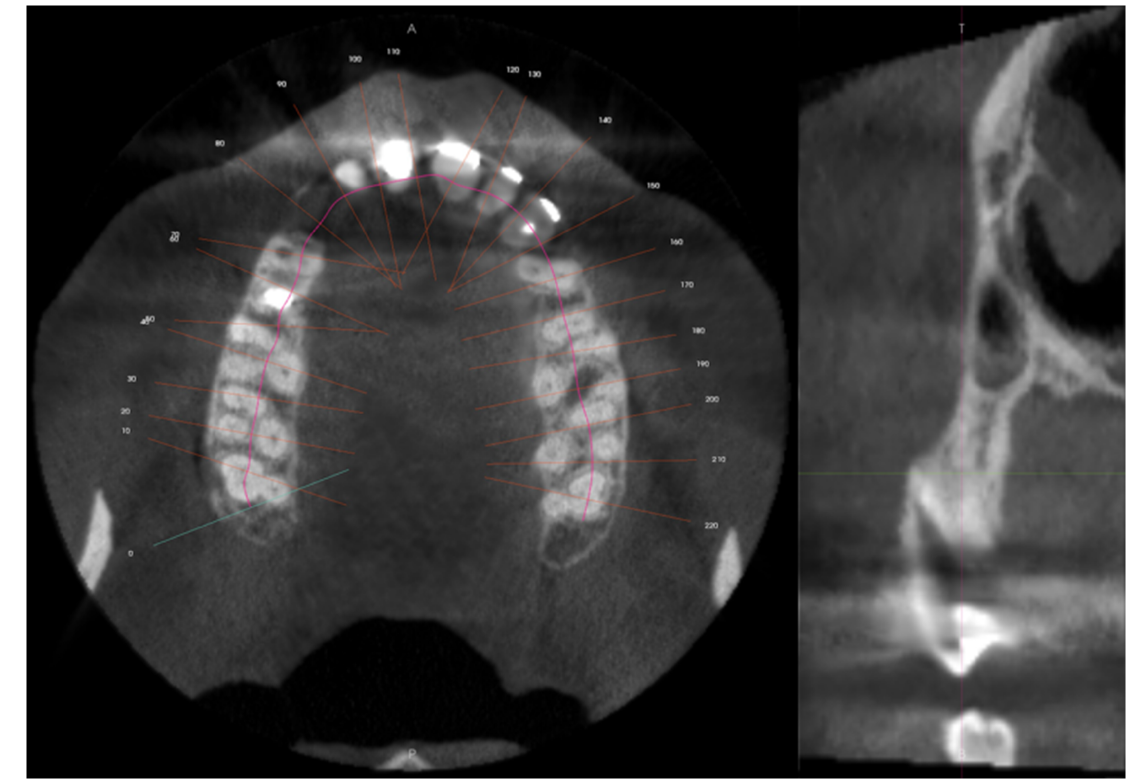
Figure 5. Cross section shows coronal stripping of vestibular root of element 14; axial sections show apical transportation.